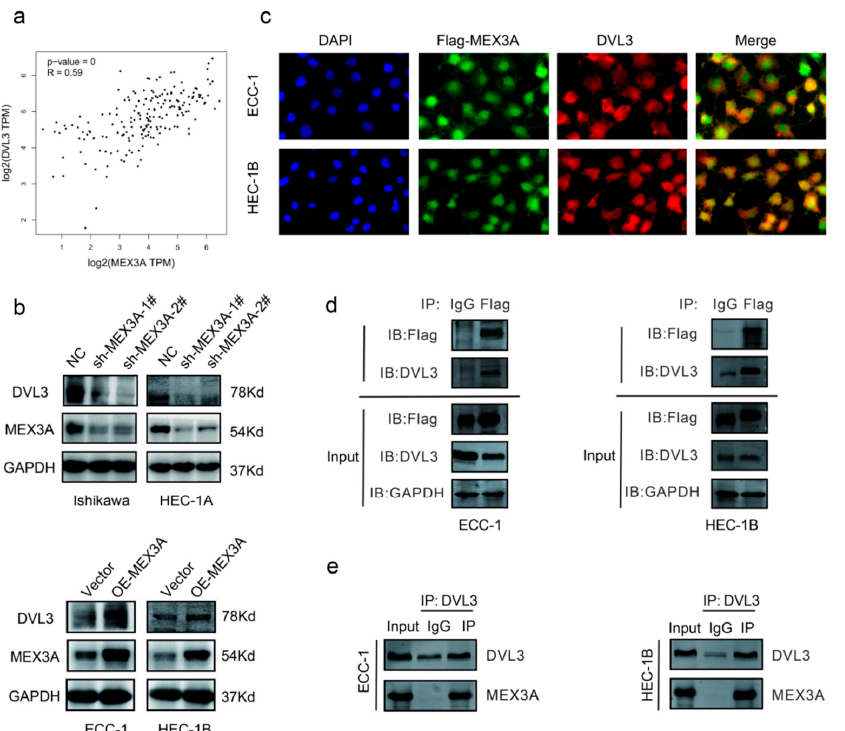
Figure 5. MEX3A enhances the Wnt/ β − catenin signaling pathway via DVL3. ( a ) Relationship be- tween MEX3A and DVL3 in TCGA (R = 0.59, p < 0.05). ( b ) The protein level of DVL3 after MEX3A knockdown or overexpression. ( c ) Immunofluorescence staining of Flag − MEX3A (green) and DVL3 (red) (400 × ). ( d , e ) Co-immunoprecipitation of MEX3A and (red) (400×). ( d , e ) Co − immunoprecipitation of MEX3A and DVL3.